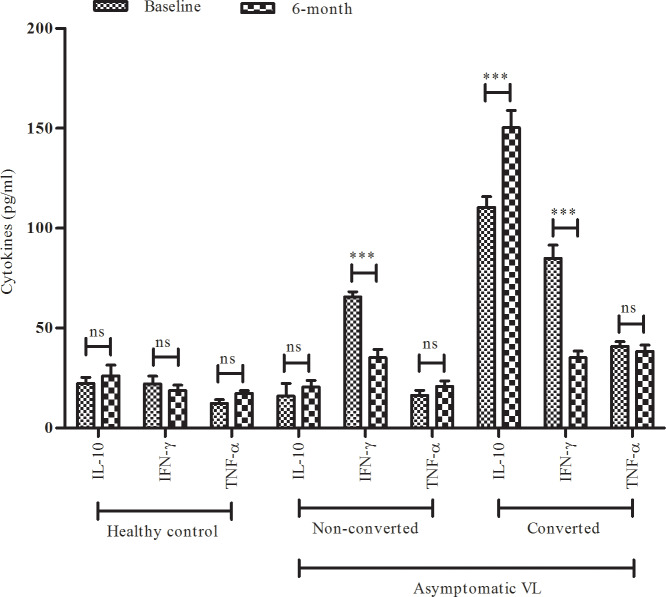
The relationship between cytokine production (IL-10, IFN-γ and TNF-α) and positivity in RT-PCR indicating subclinical infection and during the development of symptomatic visceral leishmaniasis (VL) in 10 asymptomatic residents of an endemic area of Bihar.Healthy subject (n = 10), asymptomatic VL (non-converted (n = 32) and converted into VL (n = 10)).Data were represented as mean ± SD, P≤0.05 were considered as significant.*P≤0.05, **P≤0.01, ***P ≤ 0.001, ns (non-significant).